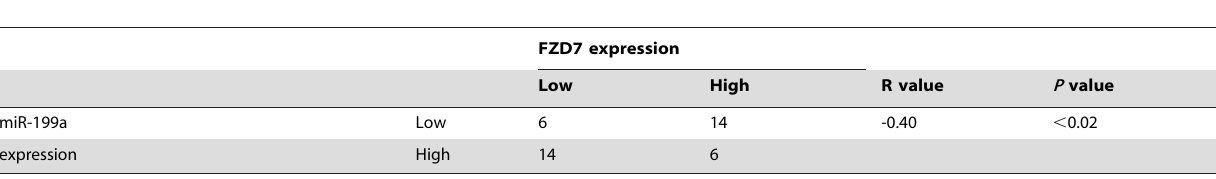
Table 5. The correlations of miR-199a with FZD7 expression in HCC tissues.